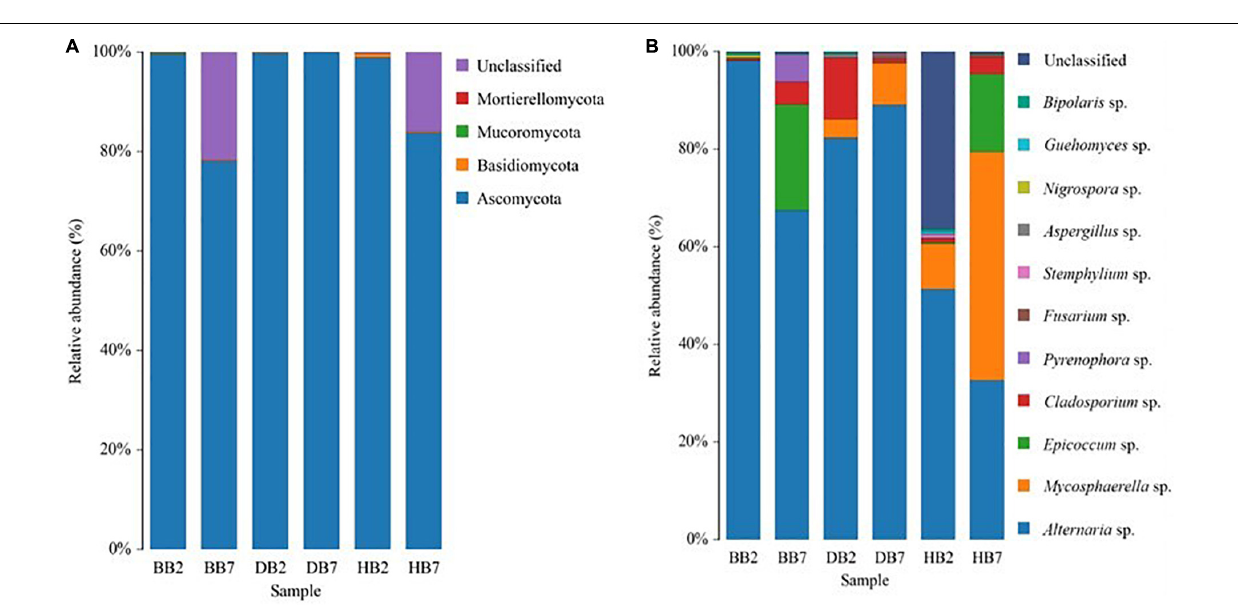
FIGURE 3 | Relative abundance of dominant fungal phyla (A) and genera (B) in different oat seed